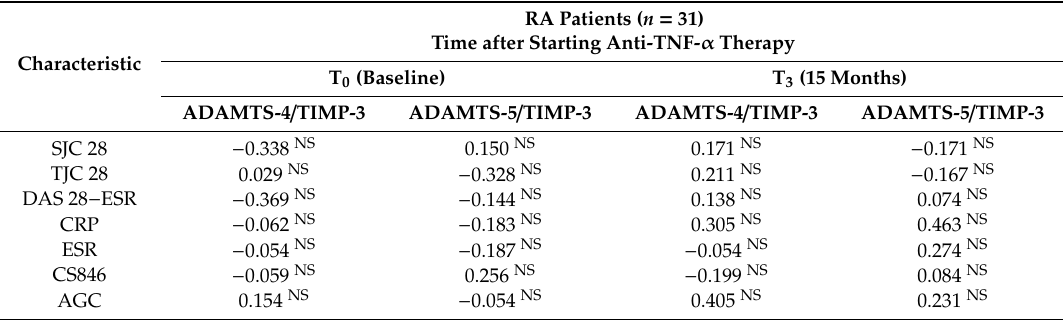
Table 5. The relationship between ADAMTS / TIMP-3 ratios and clinical (SJC, TJC, DAS28) and laboratory (ESR, CRP) indicators of disease activity as well as biomarkers of aggrecan turnover (CS846, AGC) in RA patients at baseline and after 15 months of anti-TNF- α treatment.